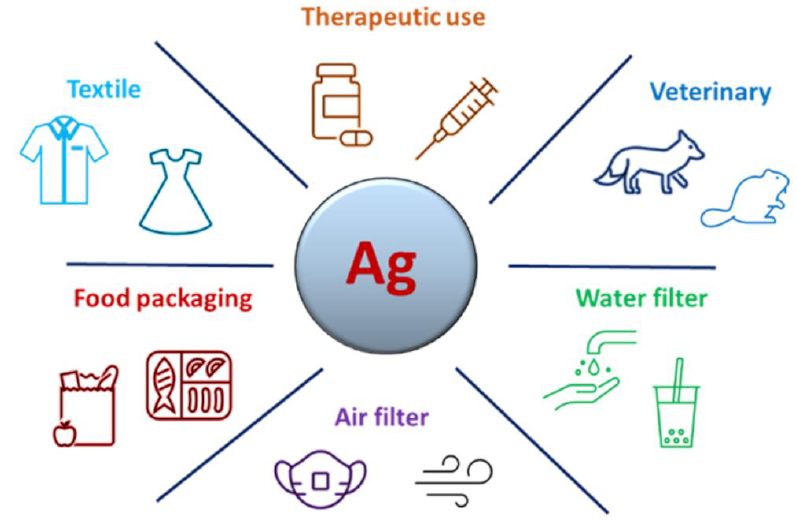
Figure 3. Main potential applications of AgNPs in the virology field.